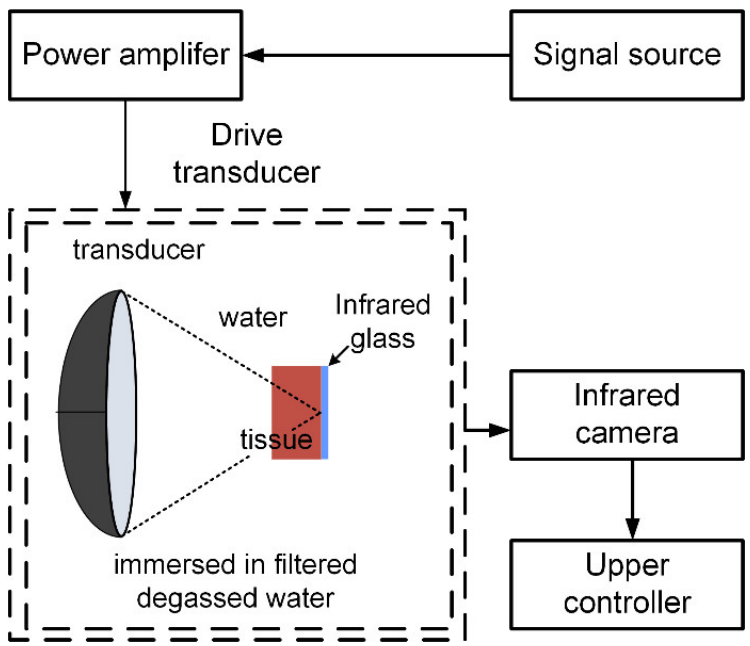
Figure 3. Schematic diagram of the experimental system.